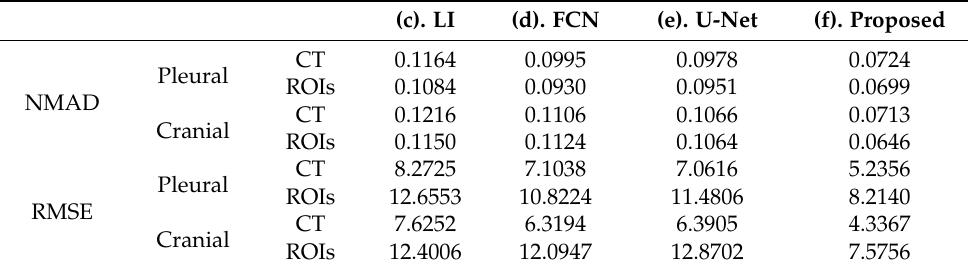
Table 2. RMSE and NMAD results of a reconstructed image in simulation